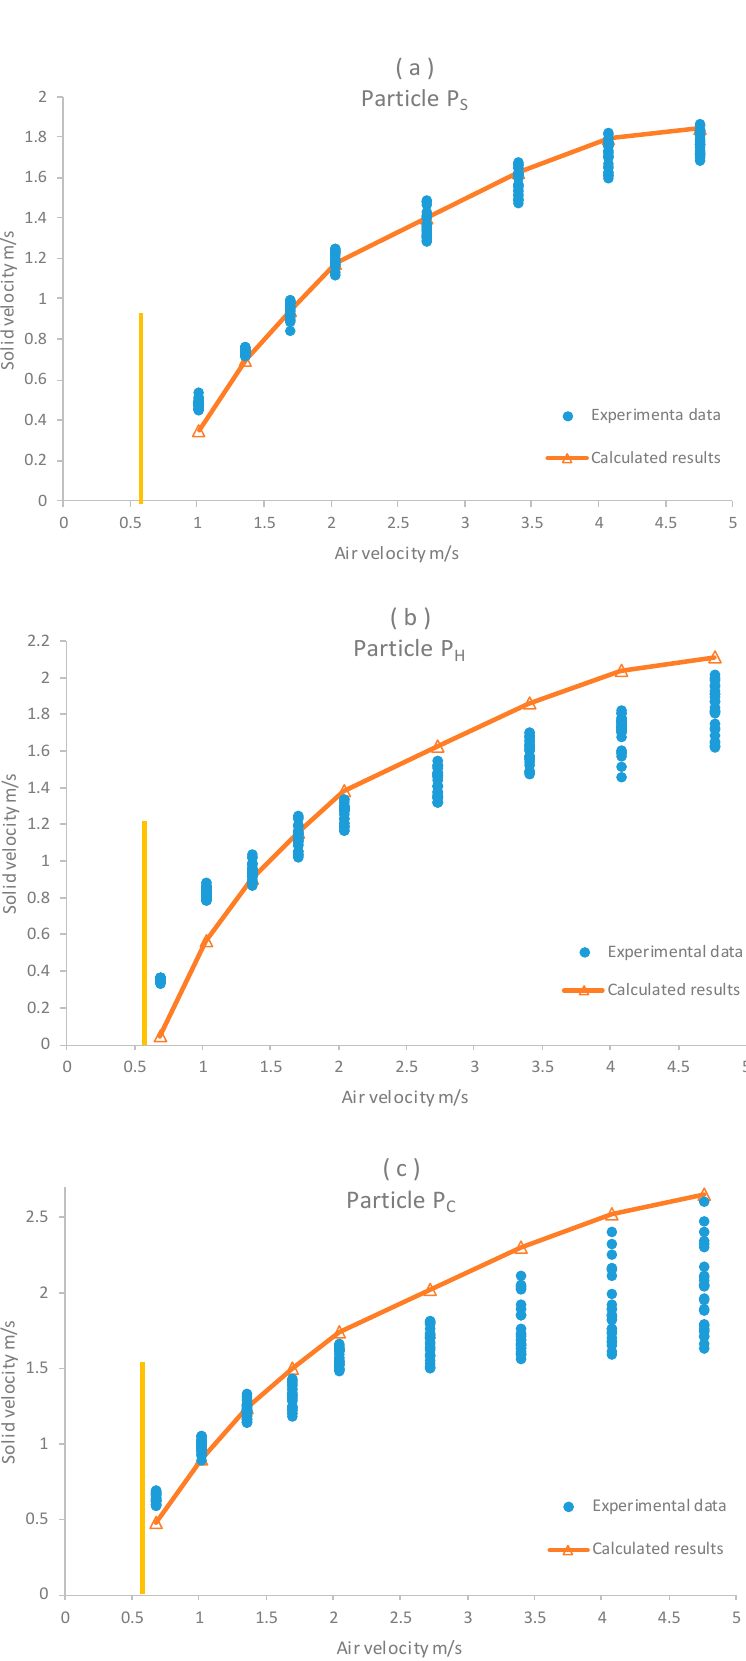
Figure 7. ( a – c ) Comparisons of the particle velocity calculated by the present method with experi- mental data for S r = 0.8.